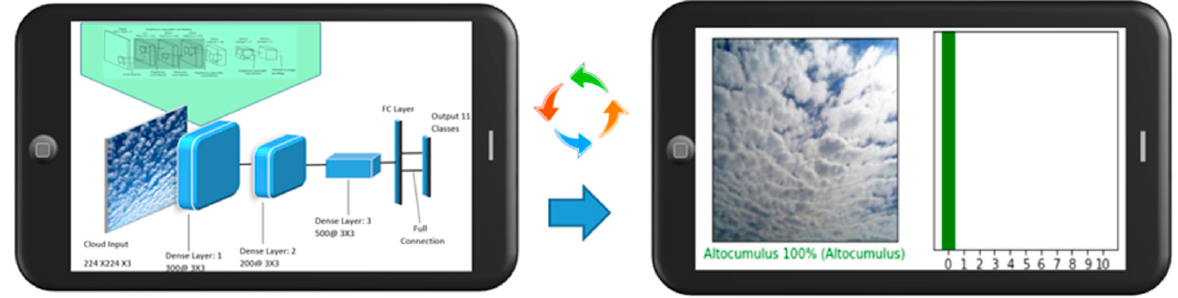
Figure 9. Smartphone’s cloud prediction app progressions .